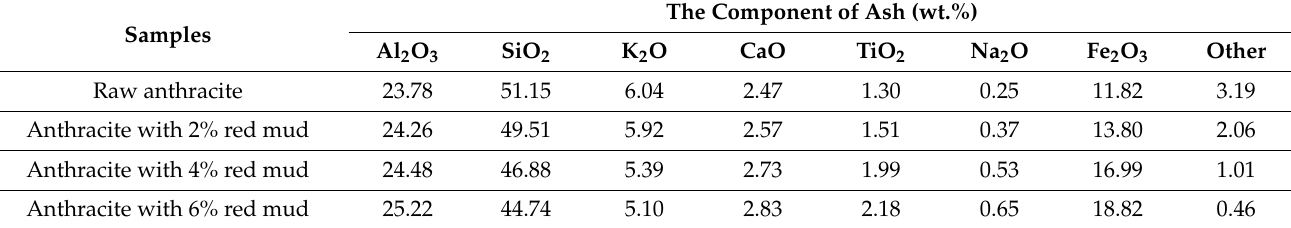
Table 4. The component of ash (wt.%).